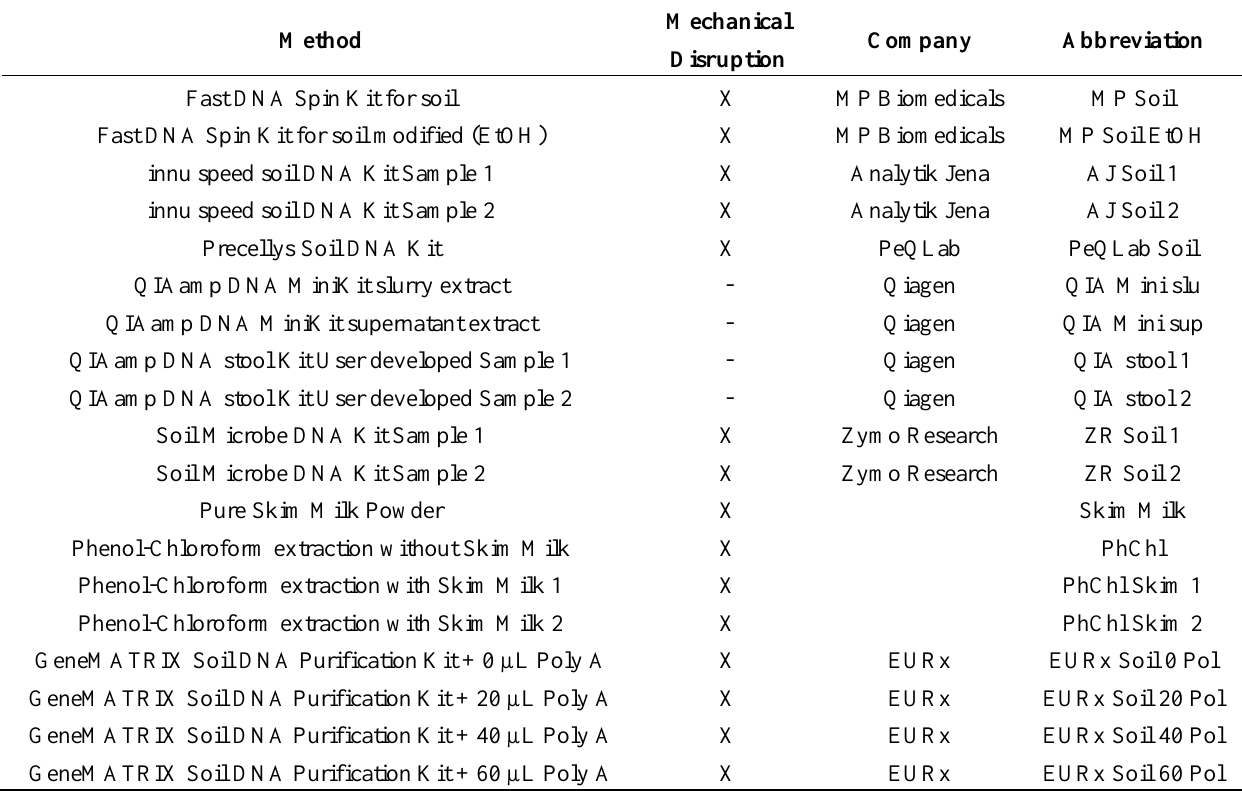
Table 1. Compared methods and